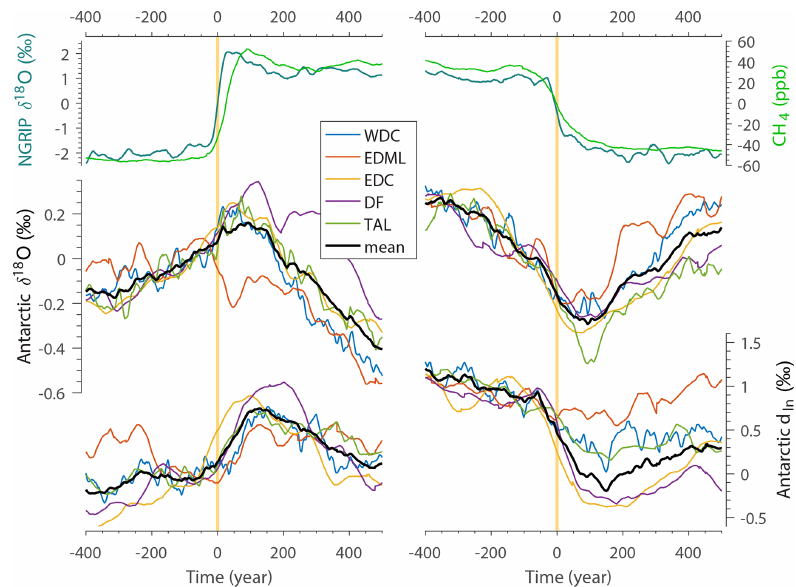
Figure 4. Stacks of isotopic records across GI onsets (a, c, e) and terminations (b, d, f) for the events listed in Table 1a and b, applying the bipolar volcanic synchronization. The time “ t = 0” refers to the midpoint of the NGRIP onset for each GI event as defined in Table 1. (a, b) Stack of NGRIP δ 18 O (blue; left axis) and WDC CH 4 (green; right axis). (c, d) Stack of Antarctic δ 18 O at the indicated locations and the average curve (mean). (e, f) Stack of Antarctic d ln at the indicated locations and the mean. The figure is modified from Buizert et al. (2018). See Fig. S15 for Antarctic core site